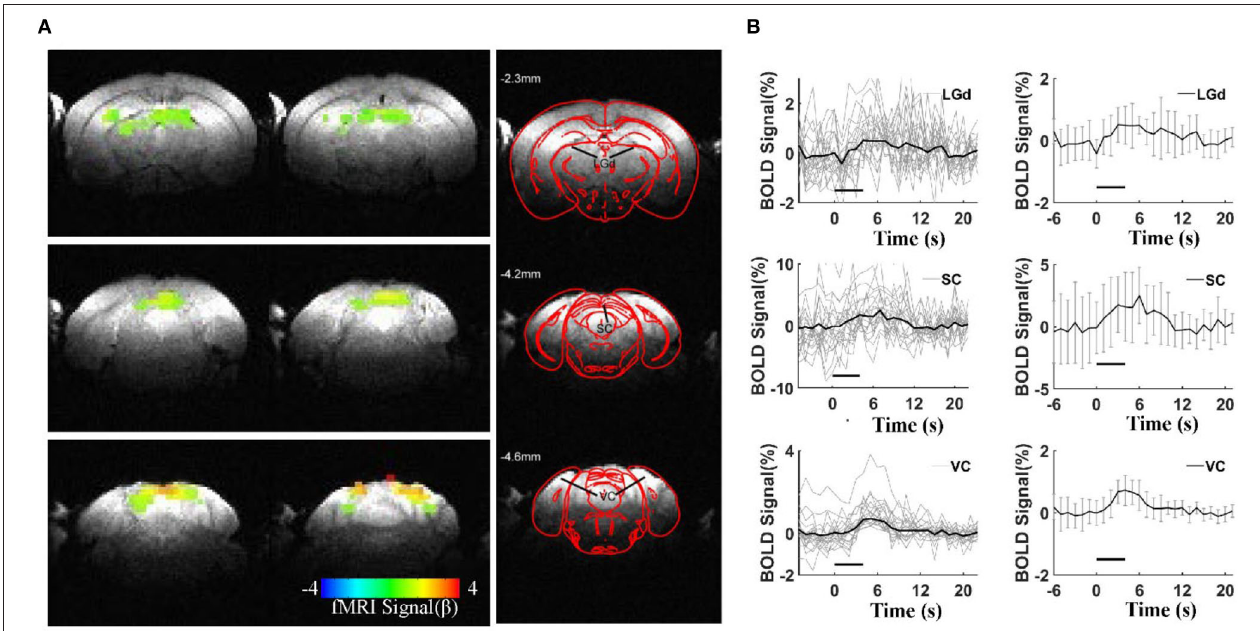
FIGURE 4 | BOLD responses under visual stimulation. (A) Representative color-coded BOLD-fMRI maps overlaid on anatomical images, showing dorsal lateral geniculate nucleus (LGd), superior colliculus (SC), and visual cortex (VC) activations in visual circuit-related regionswith a statistical threshold ( p < 0.001, cluster size > 20 voxels). (B) Averaged BOLD signals percentage changes upon visual stimulations in the visual circuit-related regions, left column: the individual epoch of signal changes from all the animals, right column: the mean BOLD signal changes (6 mice, error bars, mean ± SD, horizontal bars, duration of light